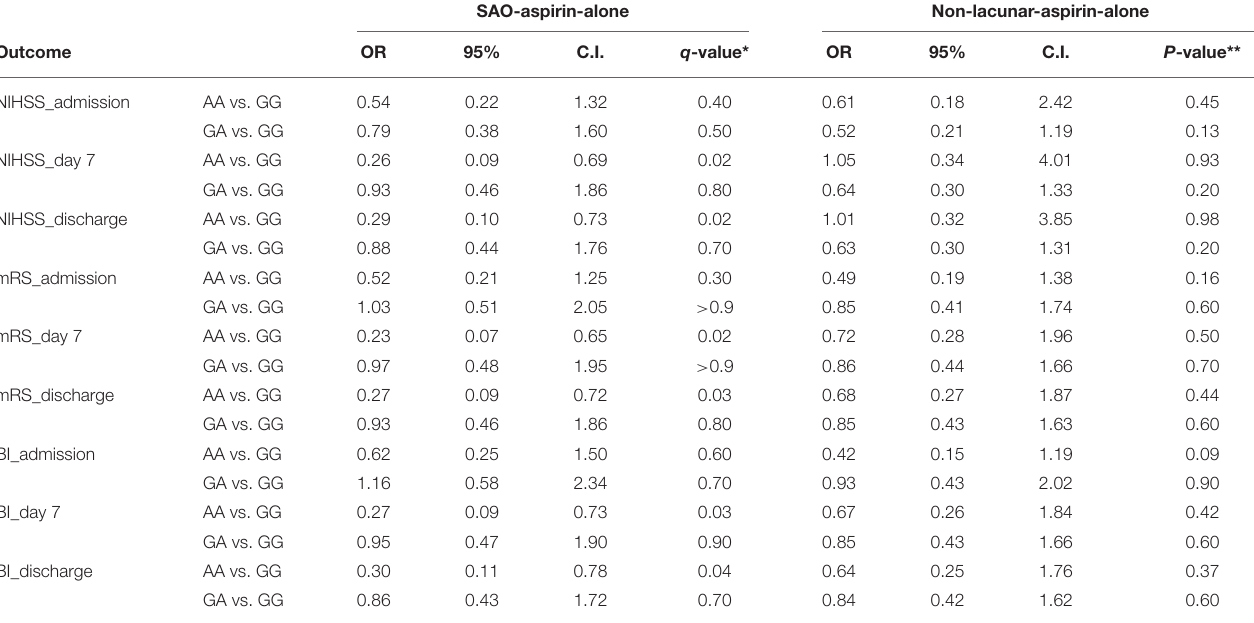
TABLE 3 | Outcome association analysis between PEAR1 SNP using univariate logistic regression models.